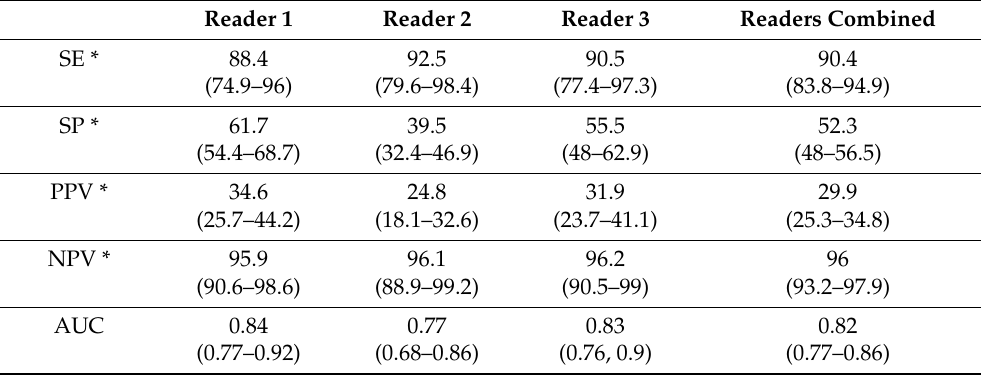
Table 2. Per prostate lobe analysis of sensitivity (SE), specificity (SP), positive predictive value (PPV), negative predictive value (NPV), and area under the curve (AUC) by individual radiologist and combined where Likert score 3 ≥ was positive scan for pathological